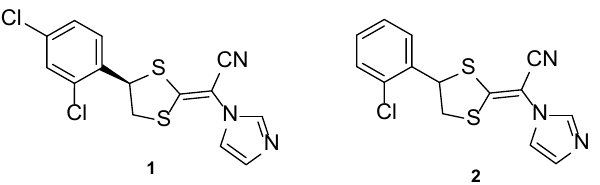
Figure 6. Chemical structures of luliconazole ( 1 ) and lanoconazole ( 2 ) [30]. Luliconazole ( 1 ) was tested using the broth microdilution method to measure the antifungal activity against Trichophyton species, using lanoconazole ( 2 ) as standard and ex-